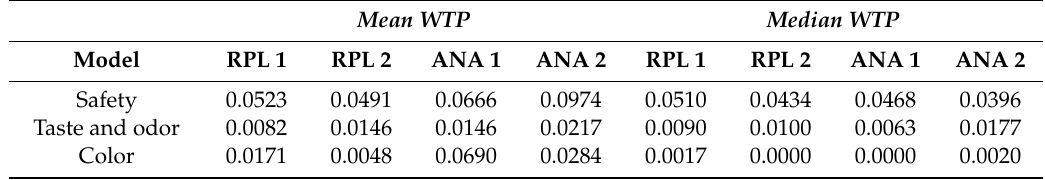
Table 4. Estimation of the mean and median WTPs (Willingness To